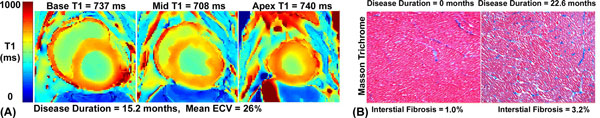
(A) Representative post-contrast AIR cardiac T1 maps of a dog with AF duration = 15.2 months: (left) basal (T1 = 737 ms), (middle), mid-ventricular (T1 = 708 ms), and (right) apical (T1 = 740 ms) planes, with mean ECV = 26%. (B) Histologic evaluation of Masson's trichrome staining of LV tissue (midwall) samples from the antero-lateral LV in different dogs sacrificed at different durations of AF: (left) baseline and (right) 22.6 months. All specimens displayed with 10× magnification.